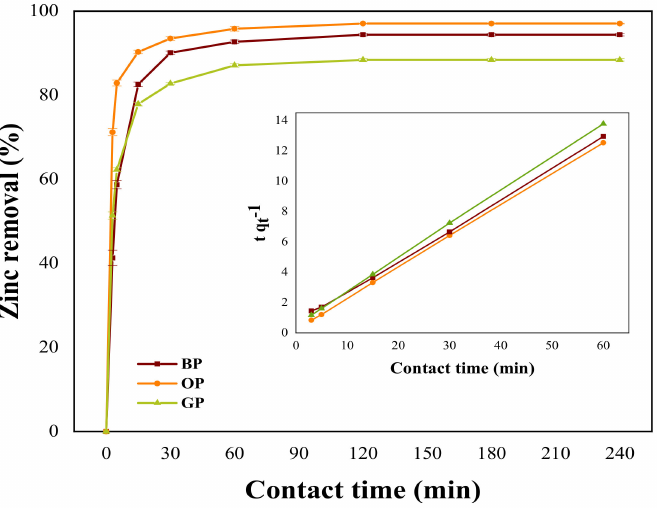
Figure 4. Kinetic profile of Zn(II) ion adsorption using the modified BP 0.8 , OP 0.8 , and GP 0.8 peel bio-adsorbents. The inset shows the kinetics